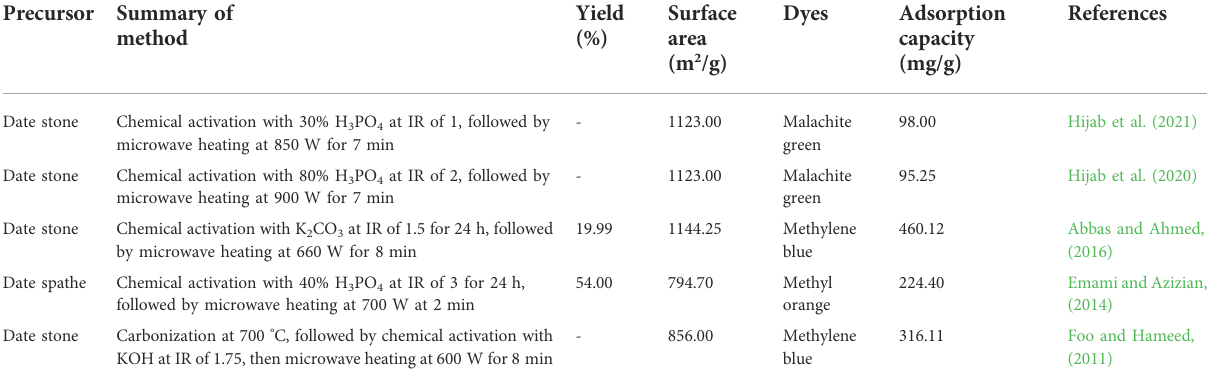
TABLE 4 Summary of works conducted in converting date palm residues into activated carbons via microwave heating. Precursor Summary of